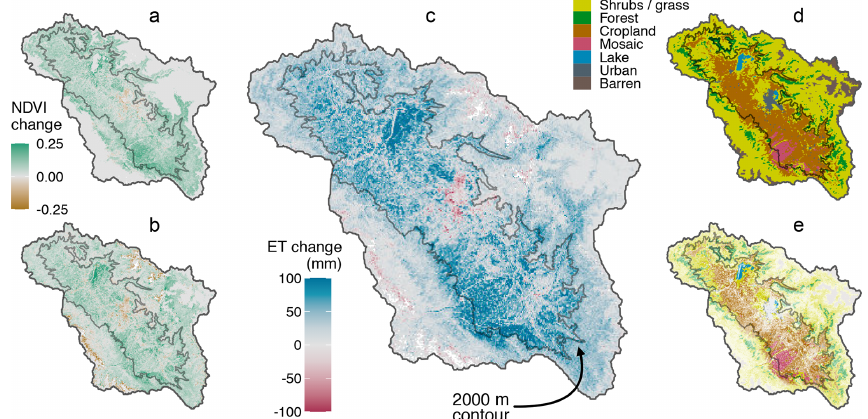
Figure 6. Spatial changes in evapotranspiration after 2000. (a) Spring and (b) summer changes in NDVI. (c) Annual change in evapotran- spiration (ET). (d) MODIS land cover map from 2010. (e) The same MODIS 2010 land cover map with the pixel transparency determined by the magnitude of positive change in annual ET from panel (c) . The 2000m contour separates the low-elevation valley from moderate elevation hillslopes in both mountain ranges. Changes in ET are clustered in the valley, especially in cropland and mosaic vegetation (i.e., orchards), with increasing ET in natural vegetation just above 2000m. See the text for